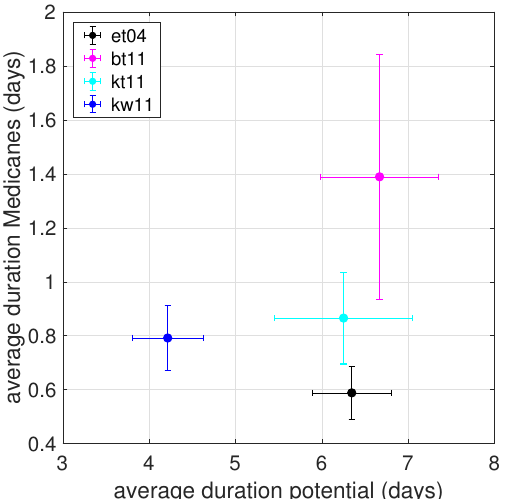
Figure 6. Scatter plot of the average duration of Medicanes, whole trajectory (horizontal axis) and Medicane state (vertical axis), for G = 3.21 × 10 − 2 hPa km − 1 . The error bars are computed as the standard deviation of the durations of the individual trajectories divided by the square root of the number of the